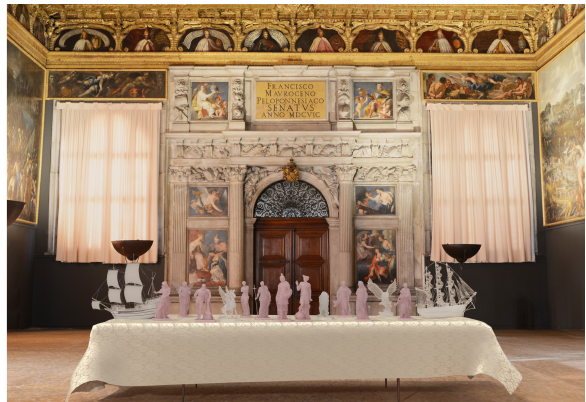
Figure 21. 3D visualization of the sugar sculptures in the Scrutinio Room.